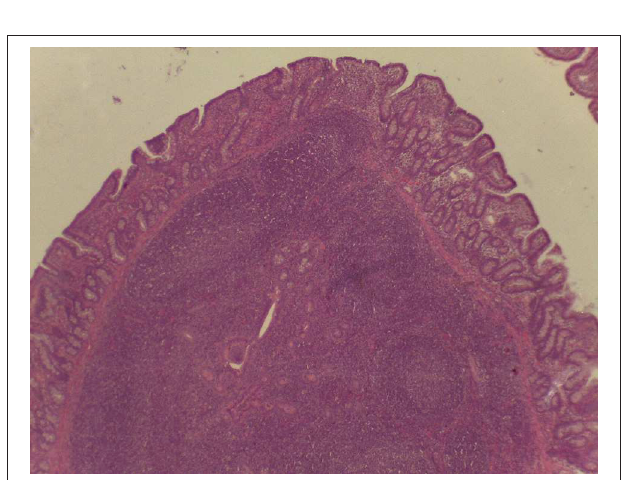
FIGURE 6 | Microscopy of PPs in pigs from the experimental group fed with the CE